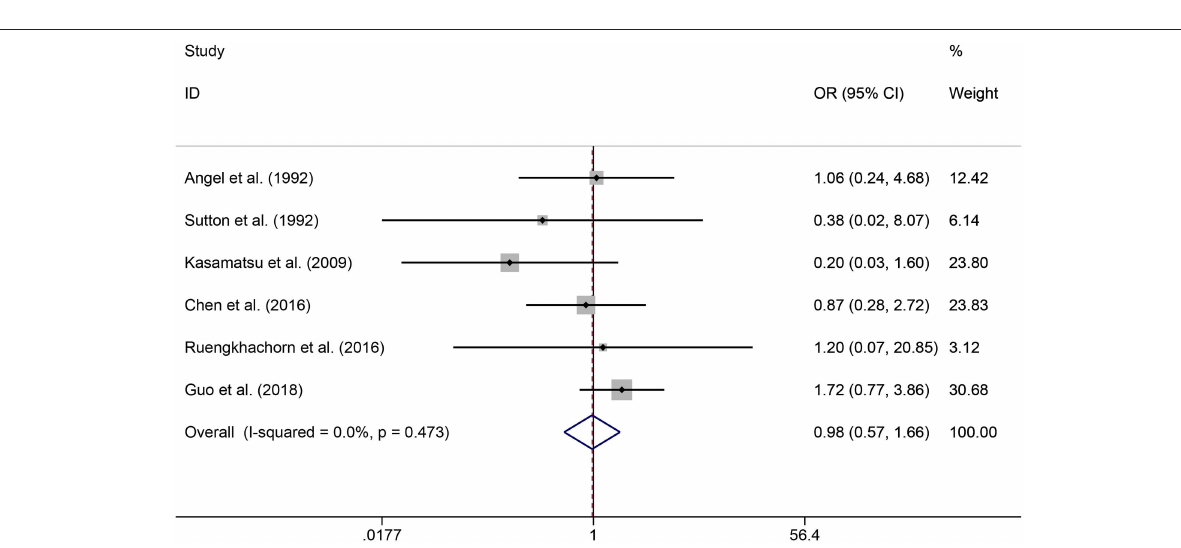
FIGURE 3 | Forest plots of PFS for ovarian preservation vs. oophorectomy in early stage cervical adenocarcinoma. Weights were from fixed-effects